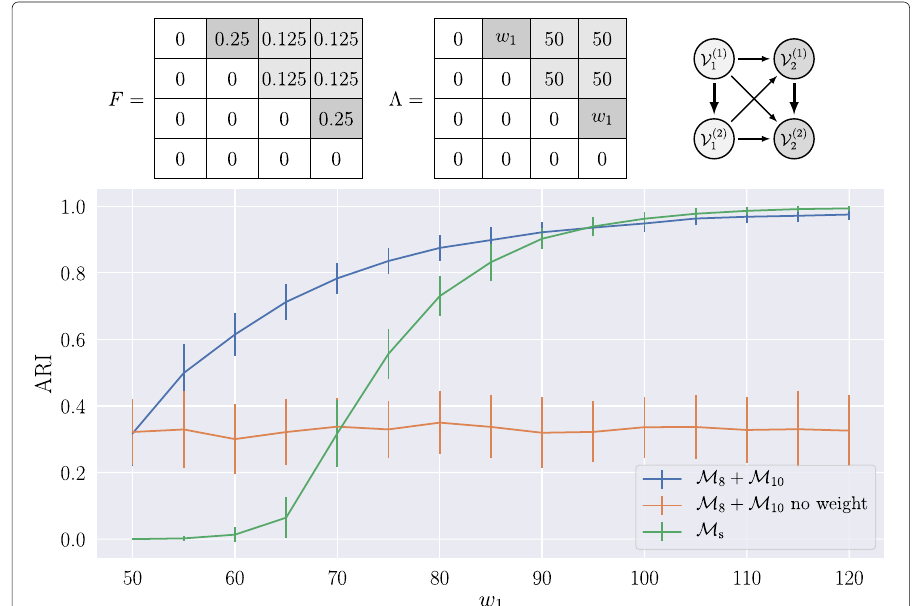
Fig. 5 Top: DSBM parameters for Example 1. We note that the DSBM has been constructed to favor weighted motifs. The left and middle panels display the connection matrix and weight matrix (Eq. 6). In the right panel, a schematic diagram of the structure, blocks of the same color belong to the same cluster and larger arrows represent connections with higher probabilities and larger edge weights. Bottom: Exploring the performance of MAMs based on M 8 and M 10 on the model in the upper panel. Each block contains 100 nodes. We compare both to the unweighted case, and to the symmetrized case. We perform 100 repeats, and error bars are one sample standard deviation